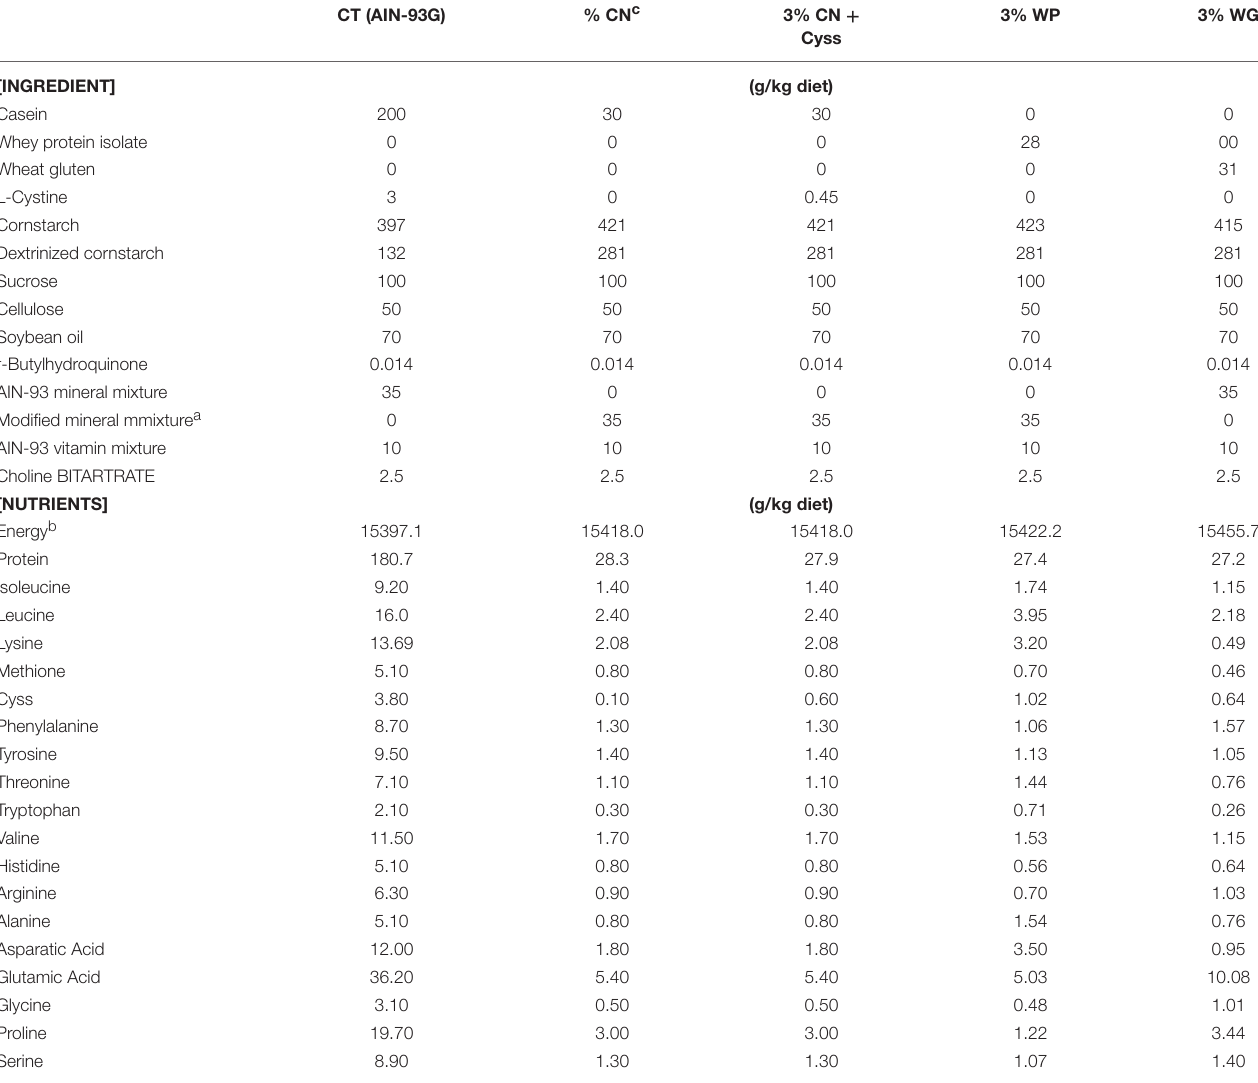
TABLE 1 | Composition of experimental diets in